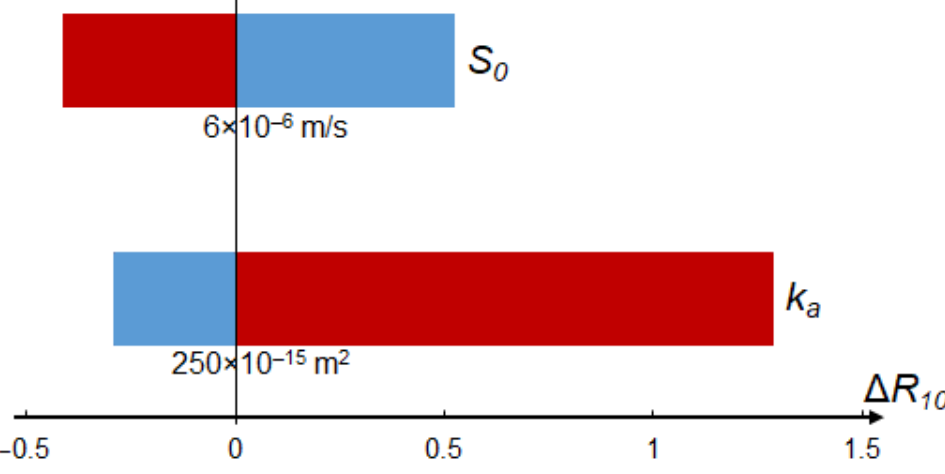
Figure 7. Sensitivity analysis of the profile conformance improvement factor from the of the heterogeneity of the reservoir.